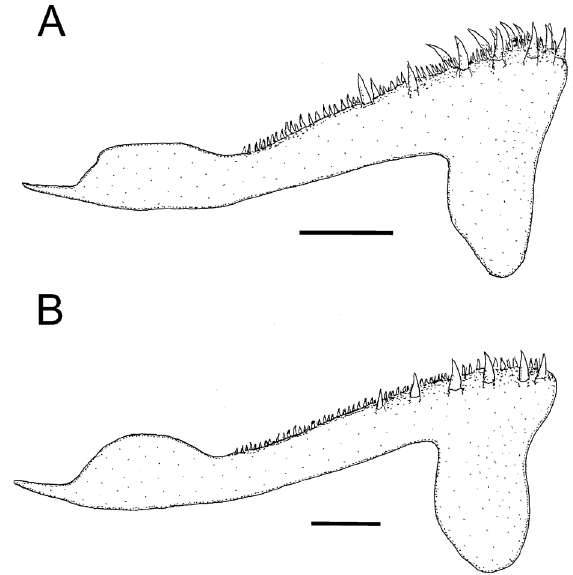
Figure 6. Left isolated premaxilla, dorsal view, ascending pro - cess inclined backwards, of: A. Nothobranchius lucius , paratype, male, MRAC A7-02-P-10-25, 43.0 mm SL. B. Nothobranchius insularis sp. n., paratype, male, MRAC A702-P-38-44, 43.7 mm SL. Scale bar = 1